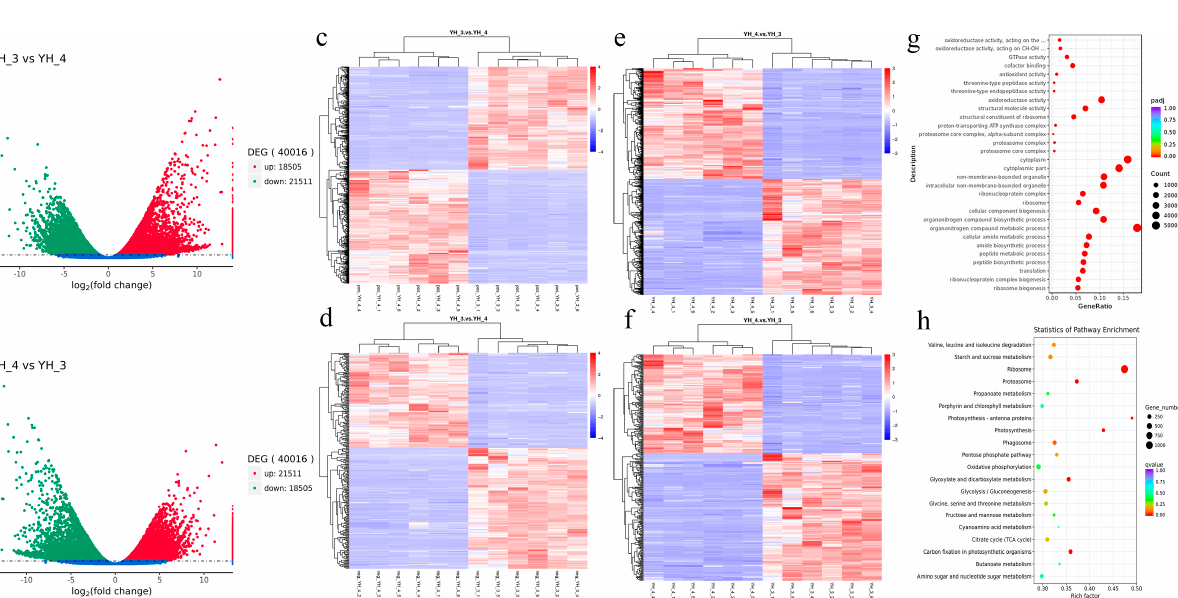
Figure 1. Functional annotations of the number of DEGs, GO classification, cluster heatmap of differentially expressed genes, and KEGG enrichment of DEGs. ( a ) Number of DEGs with YH_3 vs. YH_4. ( b ) Number of DEGs with YH_4 vs. YH_3. ( c ) Cluster heatmap of differentially expressed genes in positive polarity mode. ( d ) Cluster heatmap of differentially expressed genes in negative polarity mode. ( e ) Cluster heatmap of DEGs in positive polarity mode. ( f ) Cluster heatmap of DEGs in negative polarity mode. The abscissa in the figure represents the clustering results of samples, and the ordinate represents the clustering results of differential genes. The color represents the expression level of genes in the sample. The redder, the higher the expression, and the greener, the lower the expression. ( g ) GO classification. ( h ) KEGG enrichment of DEGs.